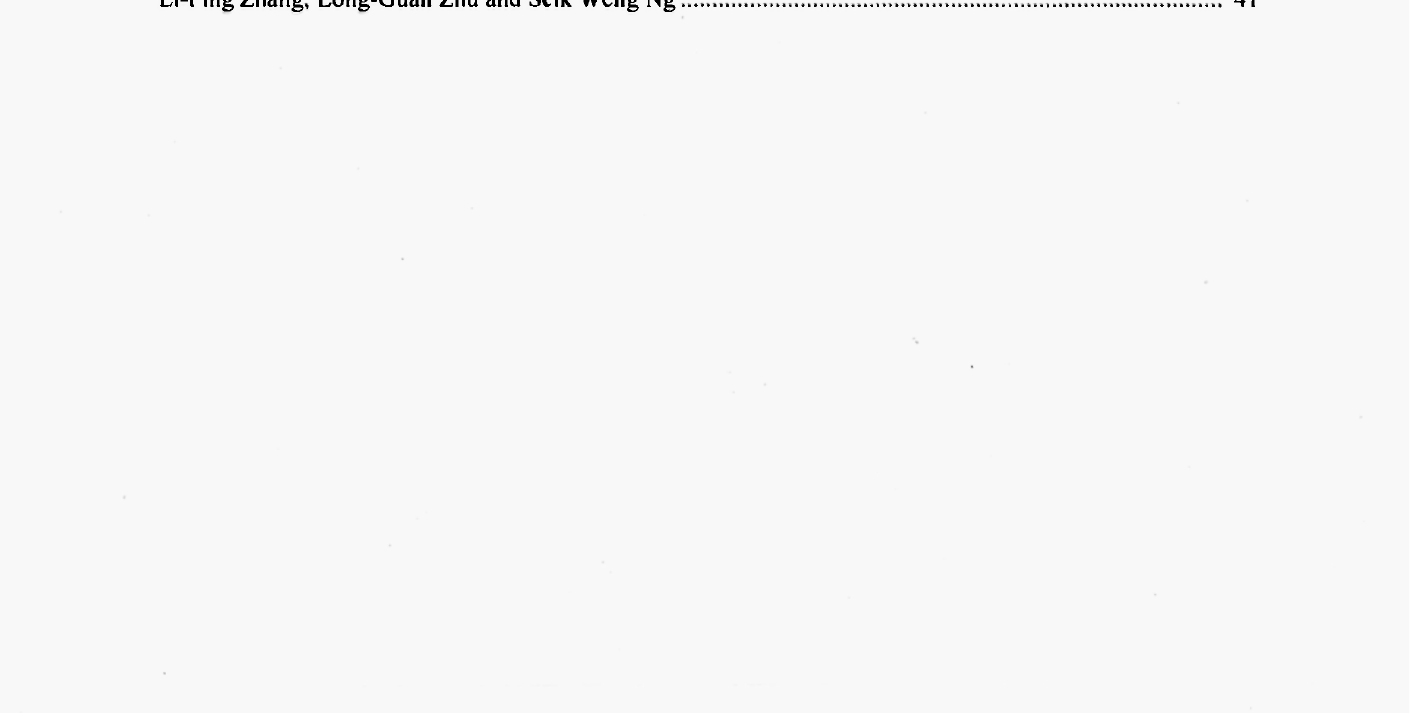
Crystal Structure of Poly-catena-diaqua (4-carboxybenzenesulfonato) Lead